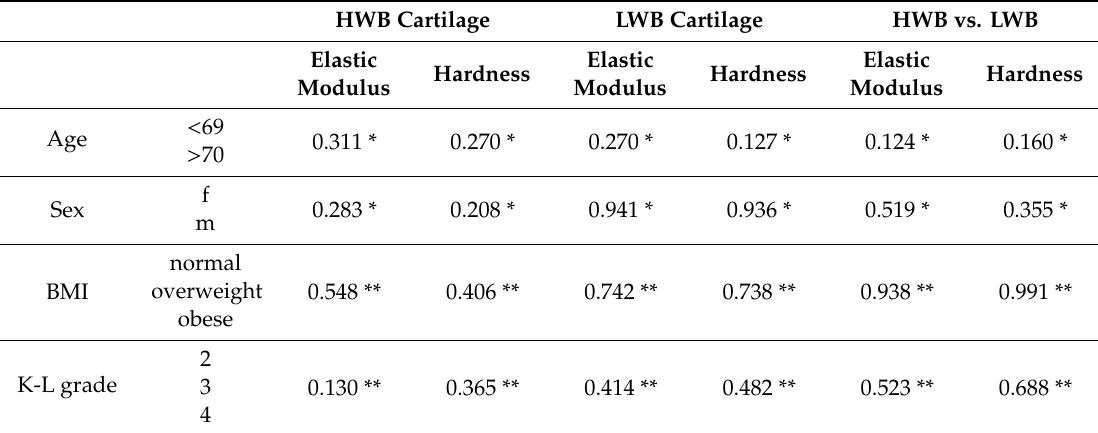
Table 6. Di ff erences between the values of elastic modulus and hardness of high weight bearing (HWB) and low weight bearing (LWB) articular cartilage adjusted to age, sex, BMI, and the K-L OA grade tested within the groups and between the groups. HWB Cartilage LWB Cartilage HWB vs. LWB